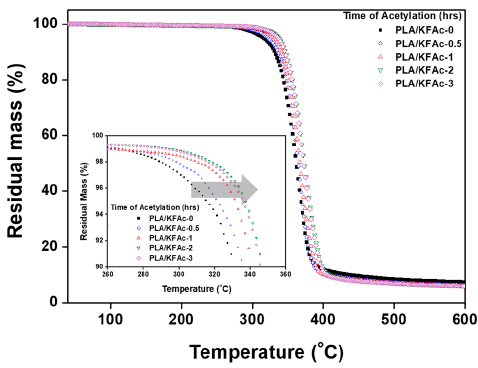
Figure 7. Thermogravimetric curves for PLA composites with untreated and acetylated kenaf.